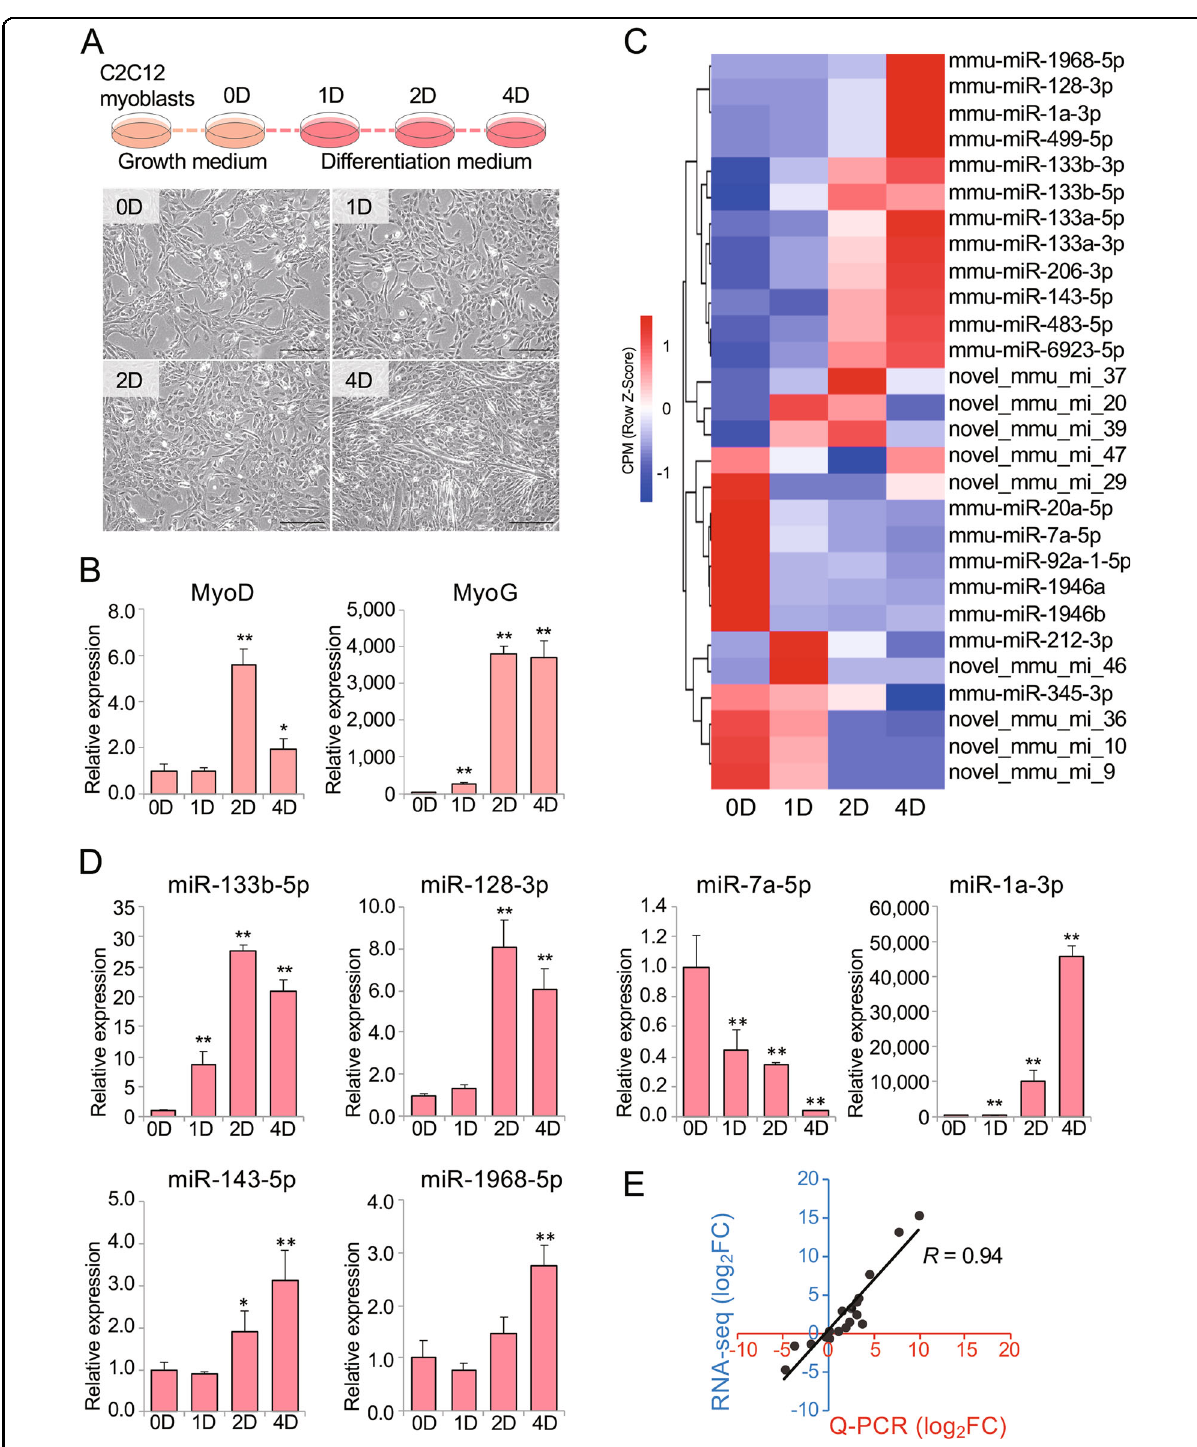
Fig. 1 Differential expression of miRNAs during C2C12 myoblast differentiation. a Schematic for stimulating the differentiation of C2C12 myoblasts into myotubes and morphological images of C2C12 myoblasts cultured in GM or in DM for 0, 1, 2, and 4 days (×100). b Expression of MyoD and MyoG during cell differentiation as determined by Q-PCR. The expression fold change is relative to day 0 in GM culture. c Hierarchical clustering of differentially expressed miRNAs on days 0, 1, 2, and 4 during C2C12 differentiation. d Expression of miRNAs on days 0, 1, 2, and 4 of cell differentiation via stem-loop Q-PCR. The expression fold change is relative to day 0 in GM culture. e Correlation analysis of stem-loop Q-PCR and miRNA sequencing data. The x -axis and y -axis show the values obtained by Q-PCR and RNA-seq, respectively. GM , growth medium; DM , differentiation medium. The error bars indicate the standard errors of the mean from three independent experiments. * p < 0.05; ** p <